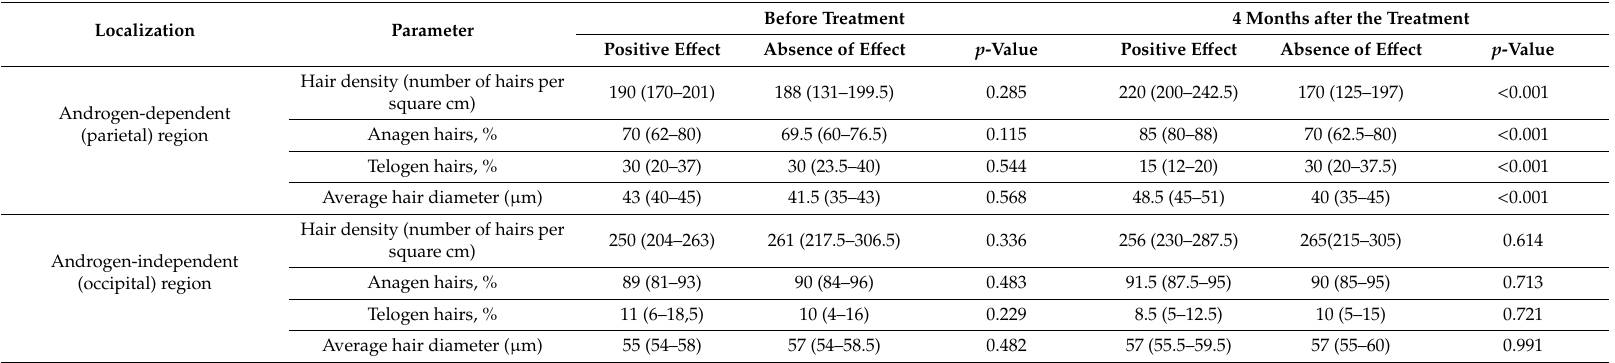
Table 1. Trichogram parameters: baseline and after 4 months of conservative therapy in groups with and without the e ff ect of AGA